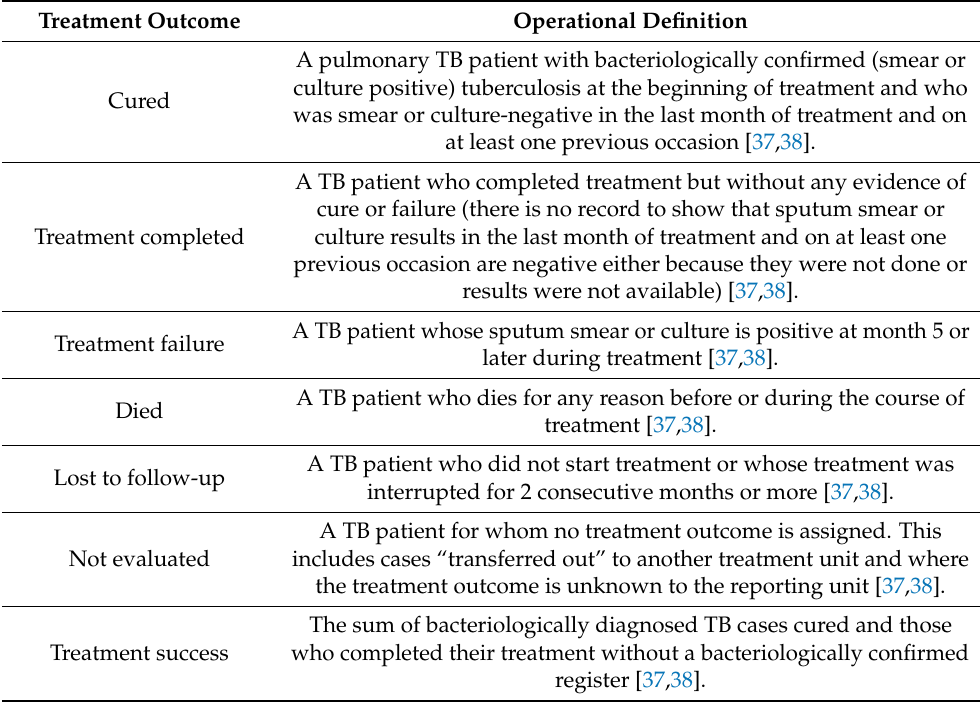
Table 1. Operational Definitions of Treatment